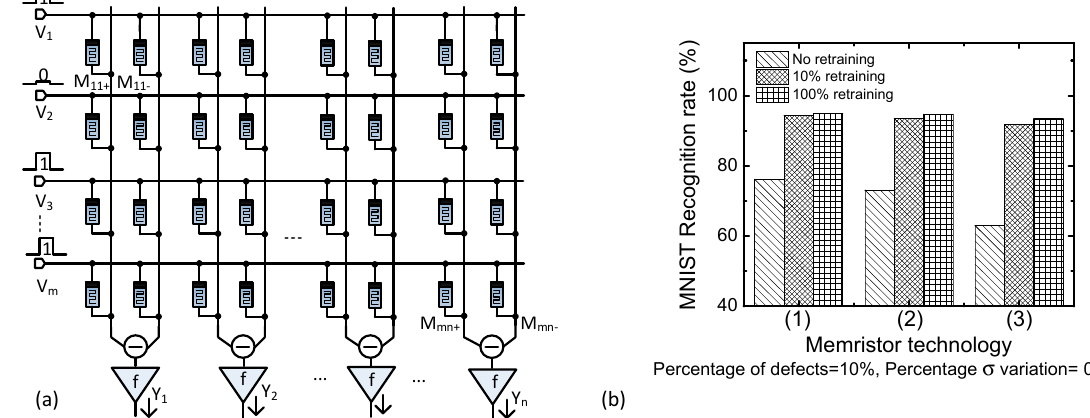
Figure 8. ( a ) Memristor Binarized NN with double-column crossbar, where memristors should be HRS and LRS not allowing intermediate values between HRS and LRS ( b ) the MNIST recognition rates of no-retraining, 100% retraining, and 10% retraining for different memristor technologies, refered in [1,11,12] . The technology (1) means the memristor measured in Figure 1b [11]. The technology (2) is from the previous publication [12]. The technology (3) is from the fabricated memristors [1].